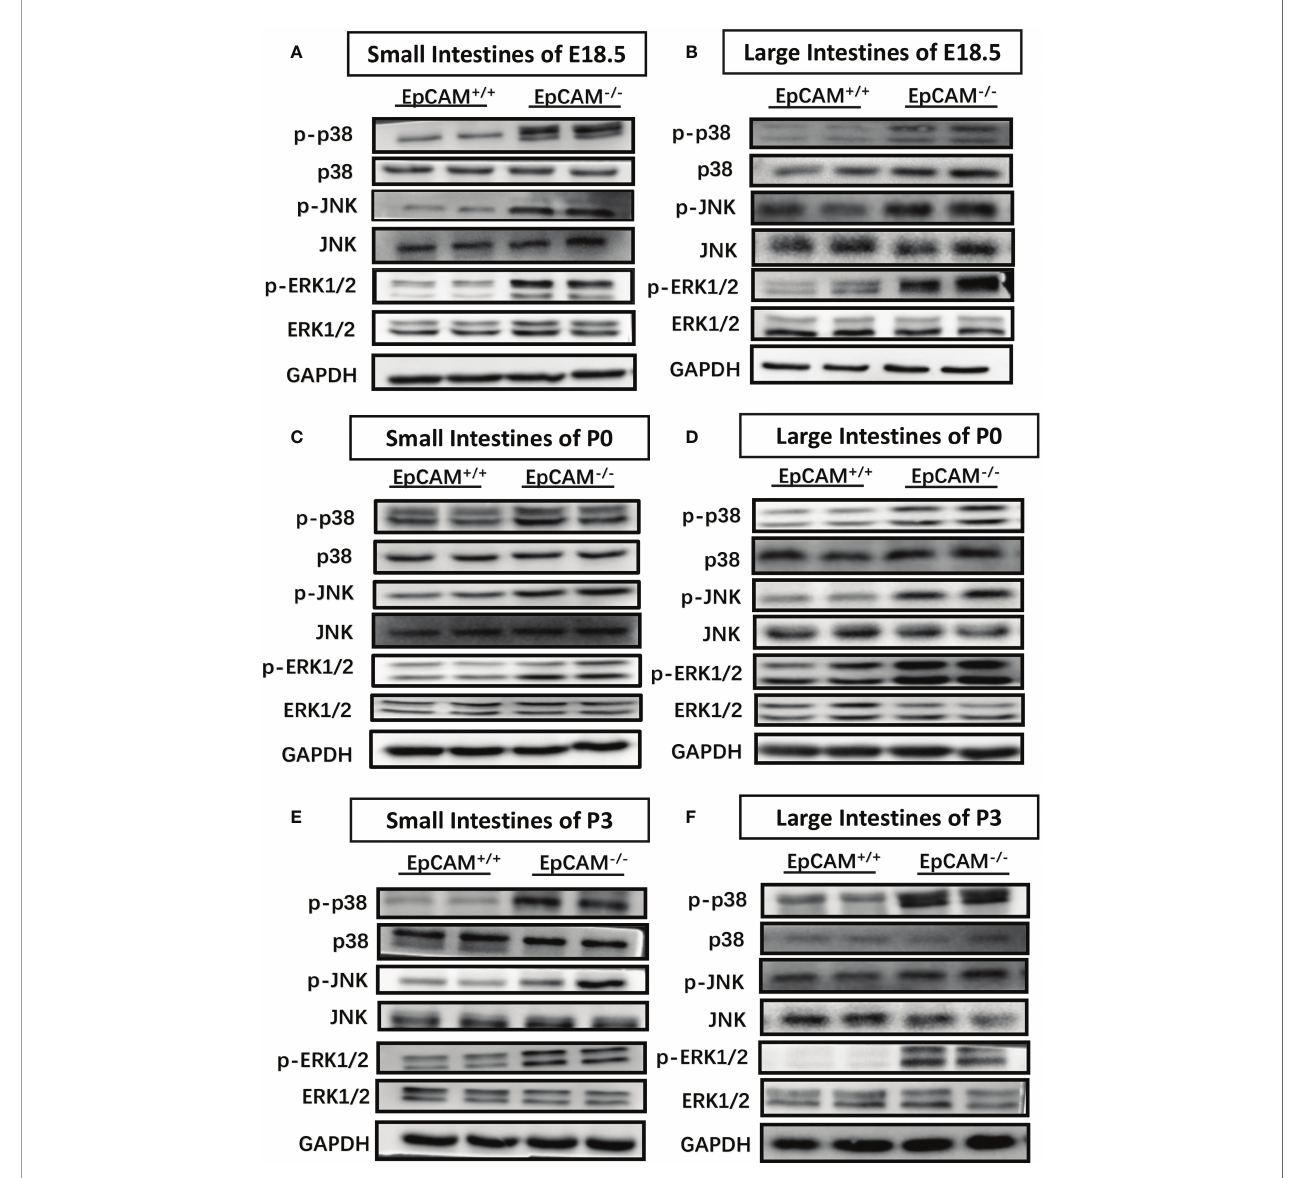
FIGURE 3 | EpCAM de fi ciency caused the hyper-activation of in fl ammation related MAPK signal pathways in the intestines of mice. (A, B) Western blot results of p- p38, p38, p-JNK, JNK, p-ERK1/2 and ERK1/2 in (A) the small intestines and (B) large intestines from WT and EpCAM -/- embryos at E18.5 stage (n=3). (C, D) . Western blot results of p-p38, p38, p-JNK, JNK, p-ERK1/2 and ERK1/2 in (C) the small intestines and (D) large intestines from WT and EpCAM -/- pups at P0 stage (n=3). (E, F) Western blot results of p-p38, p38, p-JNK, JNK, p-ERK1/2 and ERK1/2 in (E) the small intestines and (F) large intestines from WT and EpCAM -/- pups at P3 stage